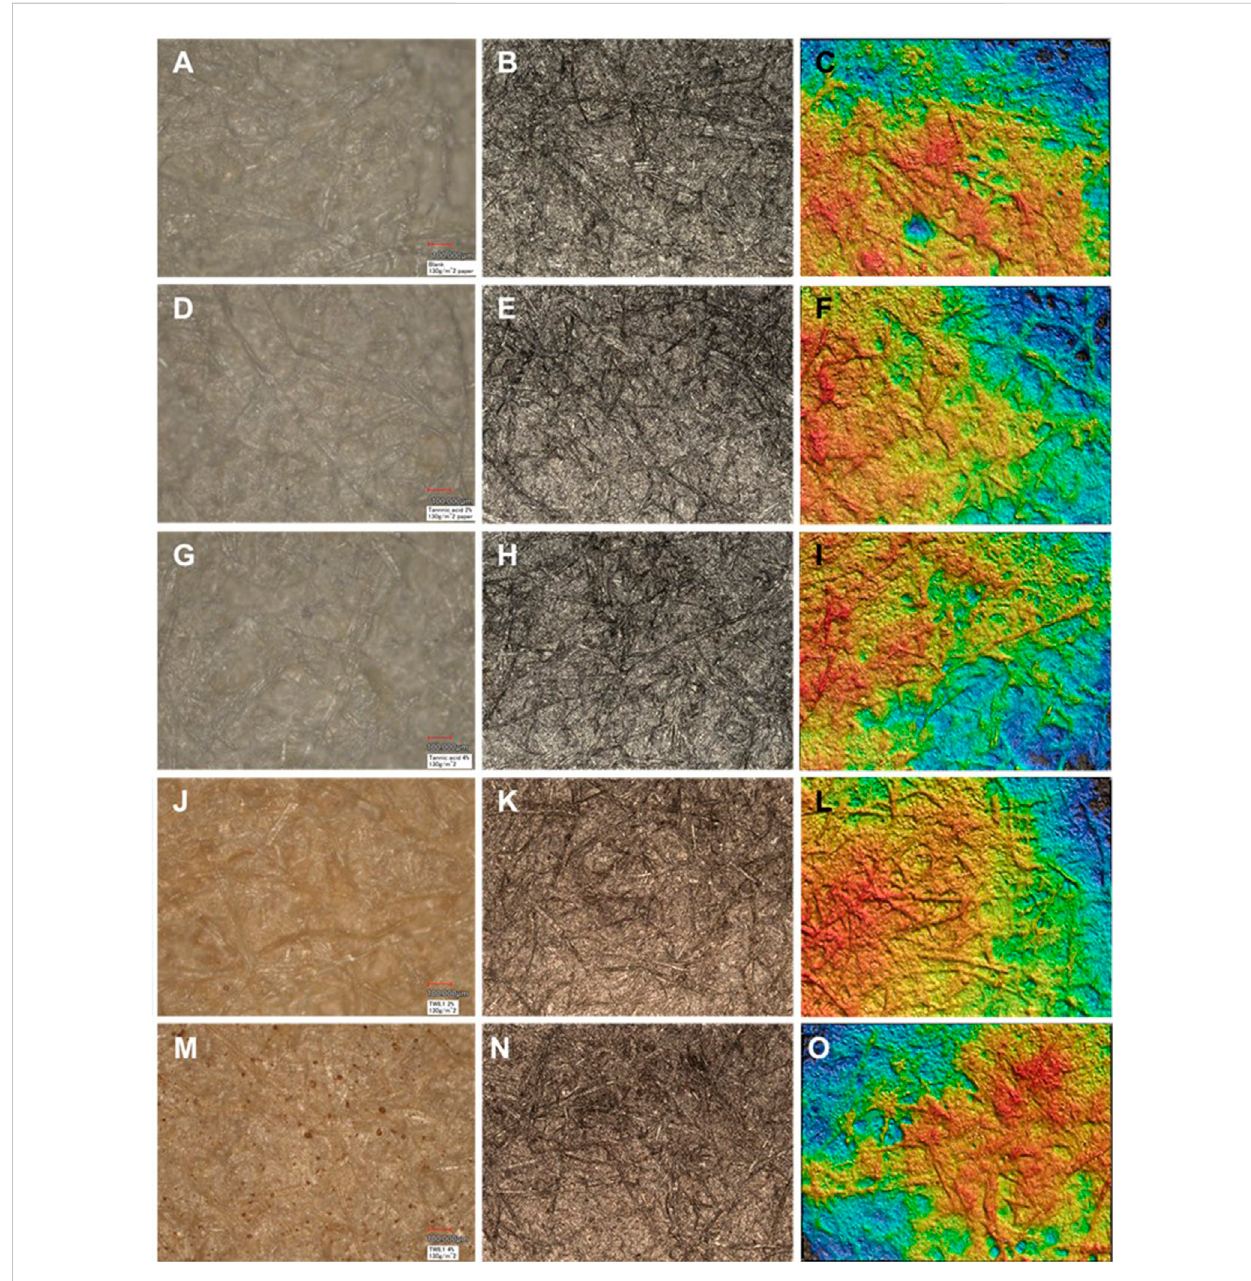
FIGURE 9 Laser microscopy of 130 g/m 2 handsheets: control (A – C) , tannic acid (TA; (D – F) 2%; (G – I) 4%), and TW extract ( (J – L) 2%; (M – O) 4%). The left side column of the sub fi gures represents opticalmicrographs; the center columns of the sub fi gures represent the laser image with color of the Extended Depth of Focus program; and the right-hand column of the sub fi gures represents the laser images as a 3D